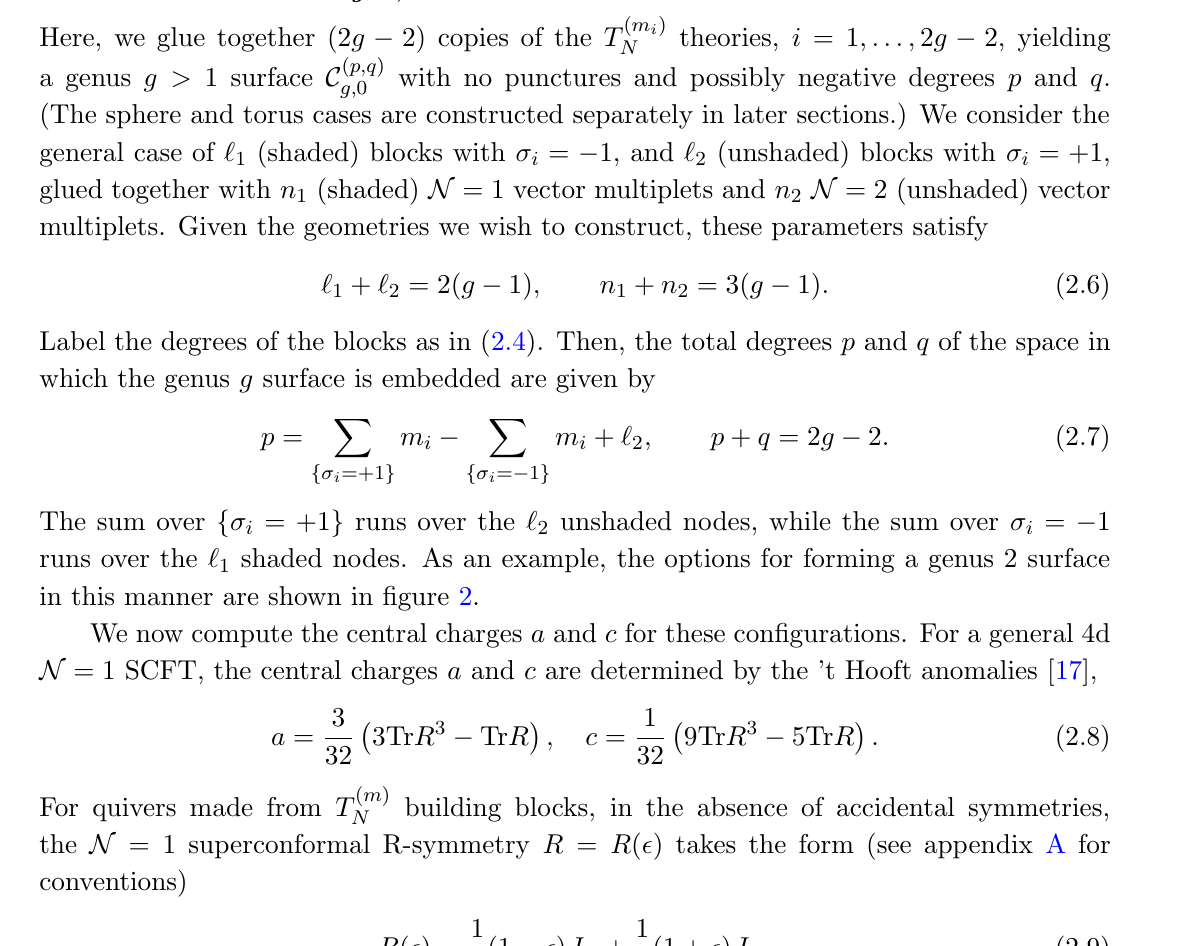
Figure 2. Options for gluing 2 T ( m i ) to T ( m i )